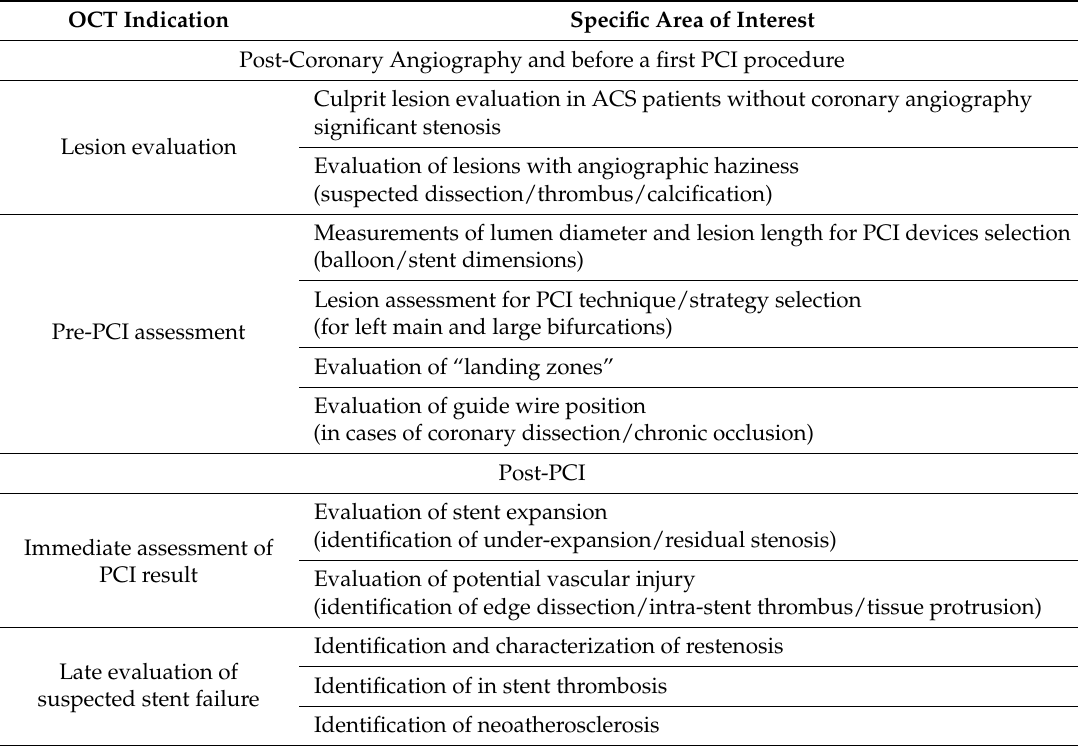
Table 1. Indications for OCT use, adapted from Tearney G.J. et al. [5], Räber L. et al. [10] and Karanasos A. et al. [16]. OCT: optical coherence tomography; PCI: percutaneous coronary intervention; ACS- acute coronary